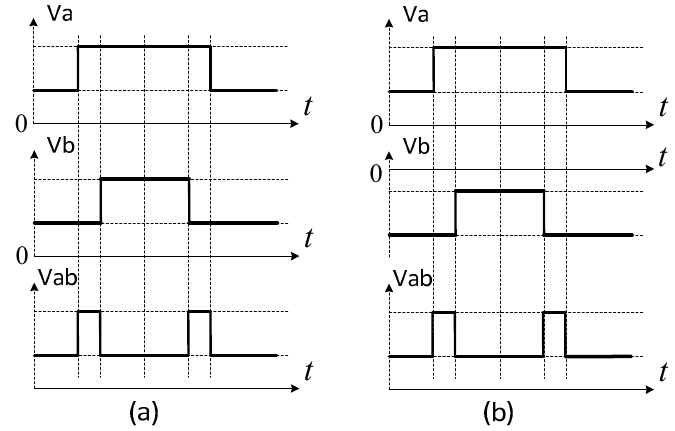
Figure 11. Different PWM phase voltages synchronization for LS PWM: ( a ) voltage pulses of the same polarity; ( b ) voltage pulses of opposite polarities.